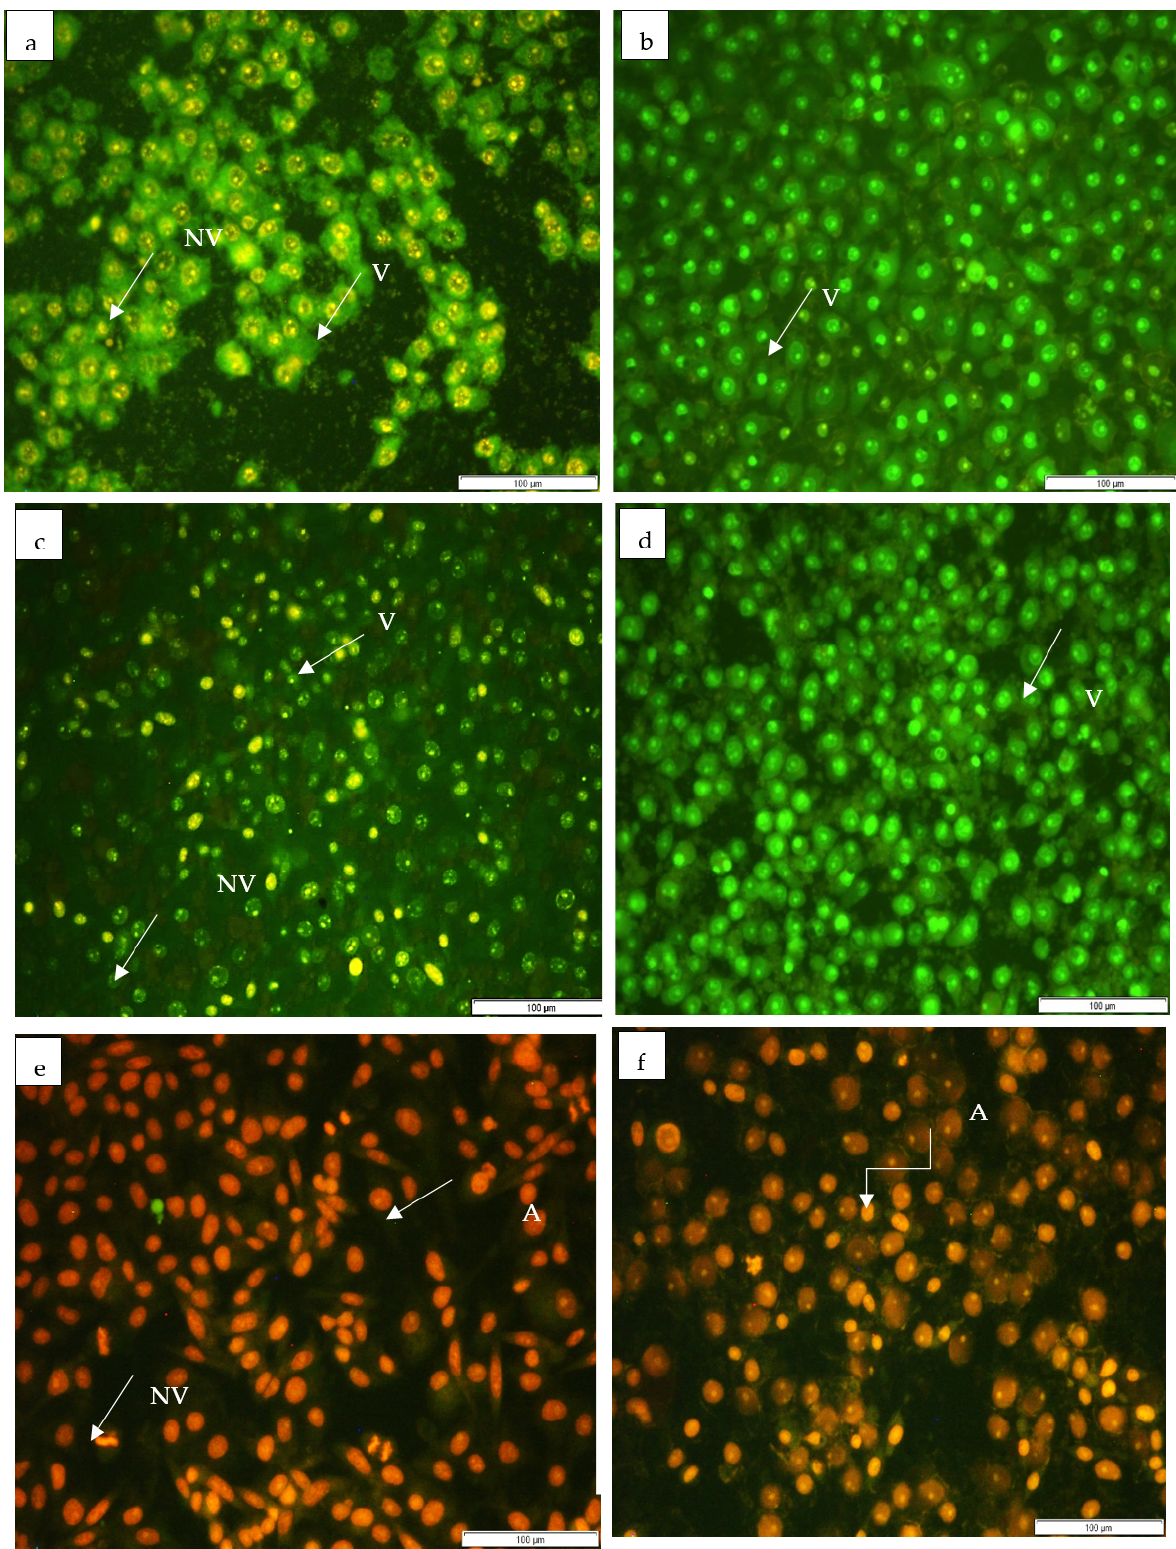
Figure 5. Light micrographs indicating the cell viability of HeLa cells stained using acridine orange and exposed to the following extracts: ( a ) leaf and ( b ) stembark hexane extract, ( c ) leaf and ( d ) stembark chloroform extract, and ( e ) leaf and ( f ) stembark methanolic extracts of C. erythrophyllum (A—apoptotic cell; V—viable cell; NV—non-viable cell).